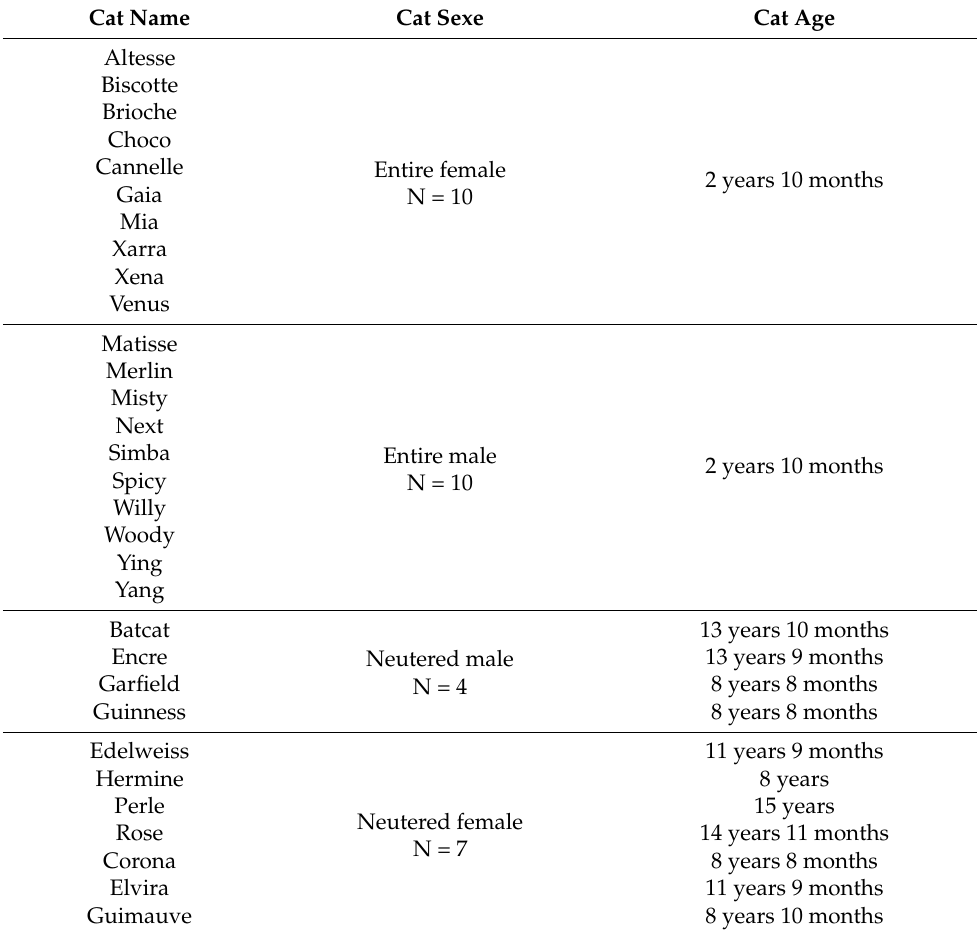
Table 1. Cats participating in the experiment, cat sexes, and ages. Entire male and female cats were born within the same two weeks so the age presented is the average age for entire male and entire female